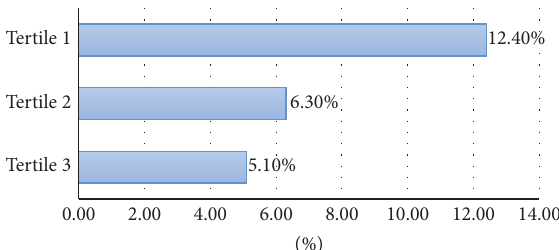
Figure 2: Total rates of HON-accredited websites among the main Western